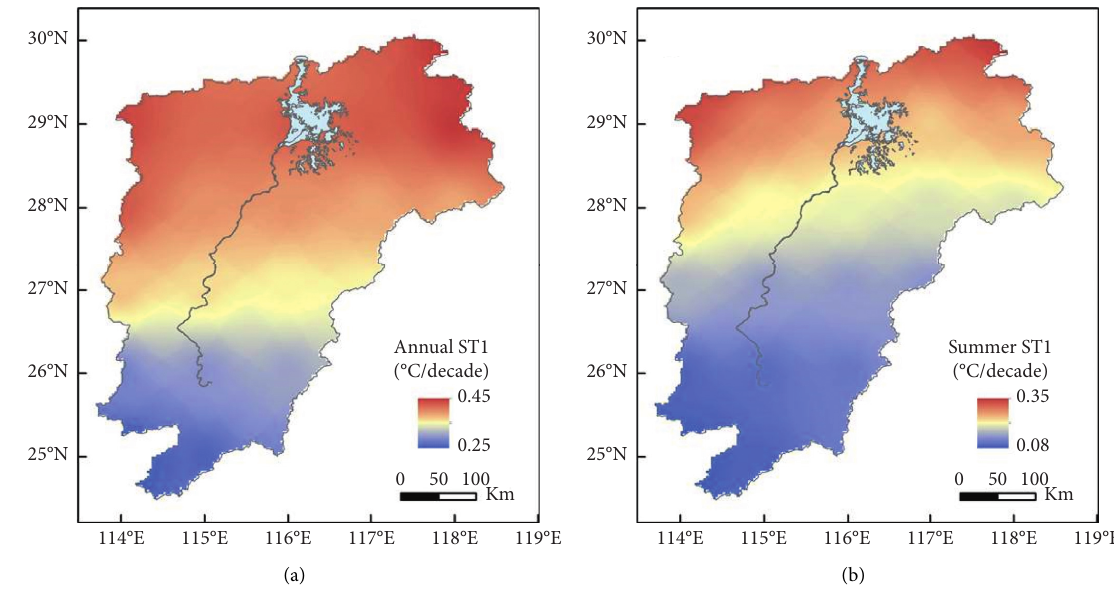
Figure 8: Spatial distribution of the climatic trend of annual soil temperature (a) and summer soil temperature (b) of ST1 over the Poyang Lake Table 5: Spatial correlation coefficient between the climatic trend of annual ST1 and soil temperatures for other depths and time periods.